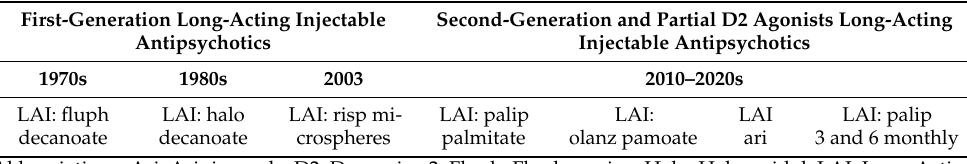
Table 3. History of the development of long-acting injectable (LAI)